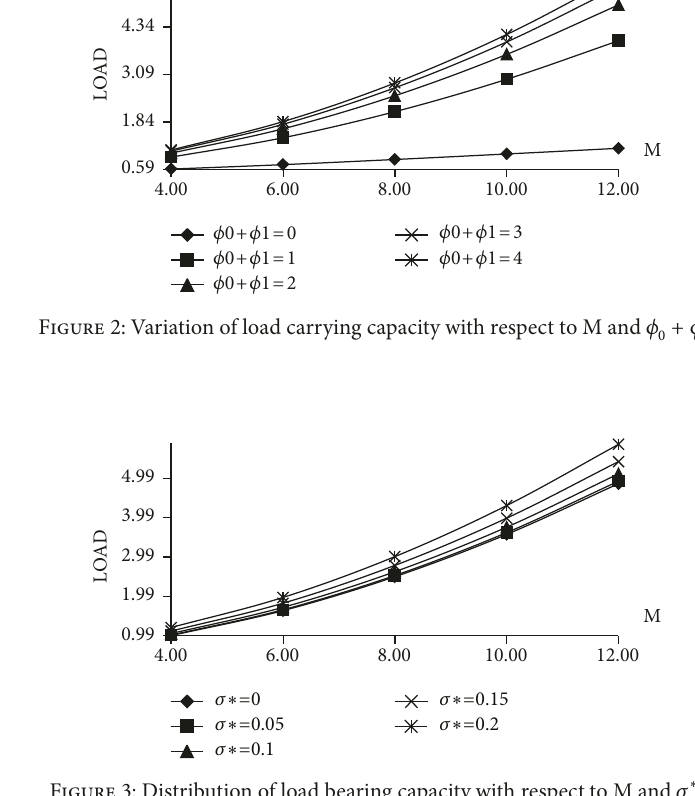
Figure 3: Distribution of load bearing capacity with respect to M and 𝜎 ∗